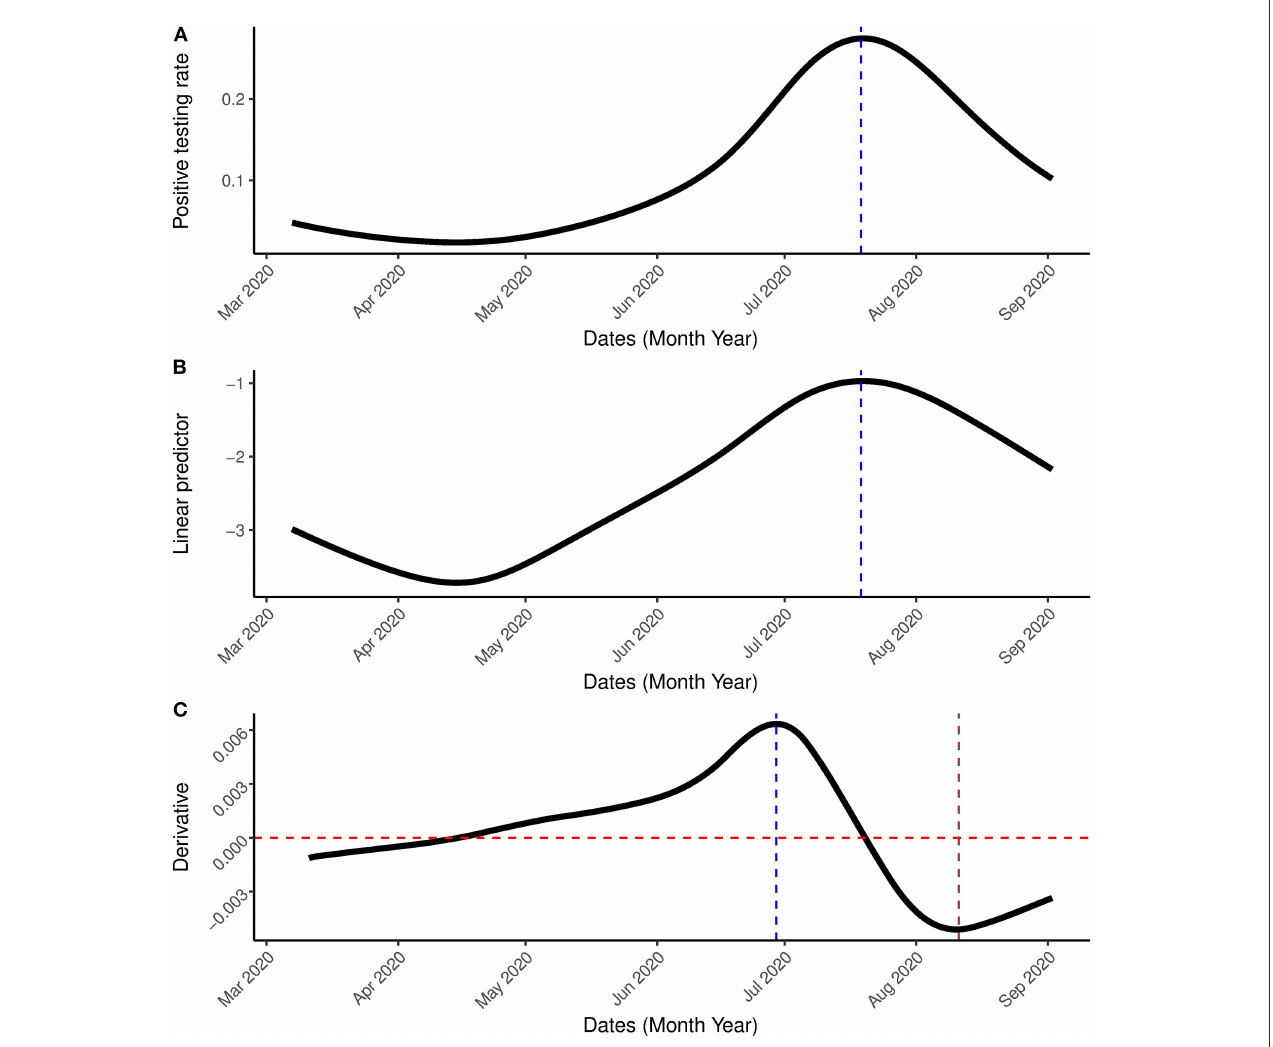
FIGURE5 Result incorporating the first wave. (A) Is the estimated positive testing rate with 95% simultaneous confidence band. (B) Is the linear predictor of the smoother with 95% simultaneous confidence band. (C) Is the first order derivative of the estimated probability with 95% simultaneous confidence band between March 7th, 2020 and September 2nd, 2020. The blue vertical line represents the peak, the pink vertical line represents the date in which the rate of change started to increase while the red horizontal line represents the rate of change at